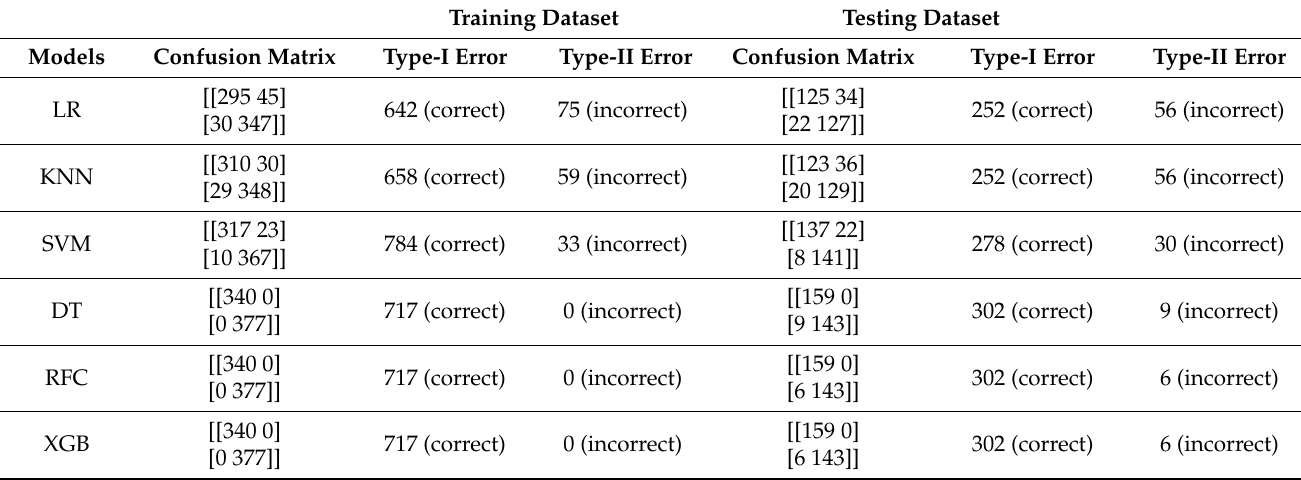
Table 10. Performance evaluation and comparison of the confusion matrix for the training and testing